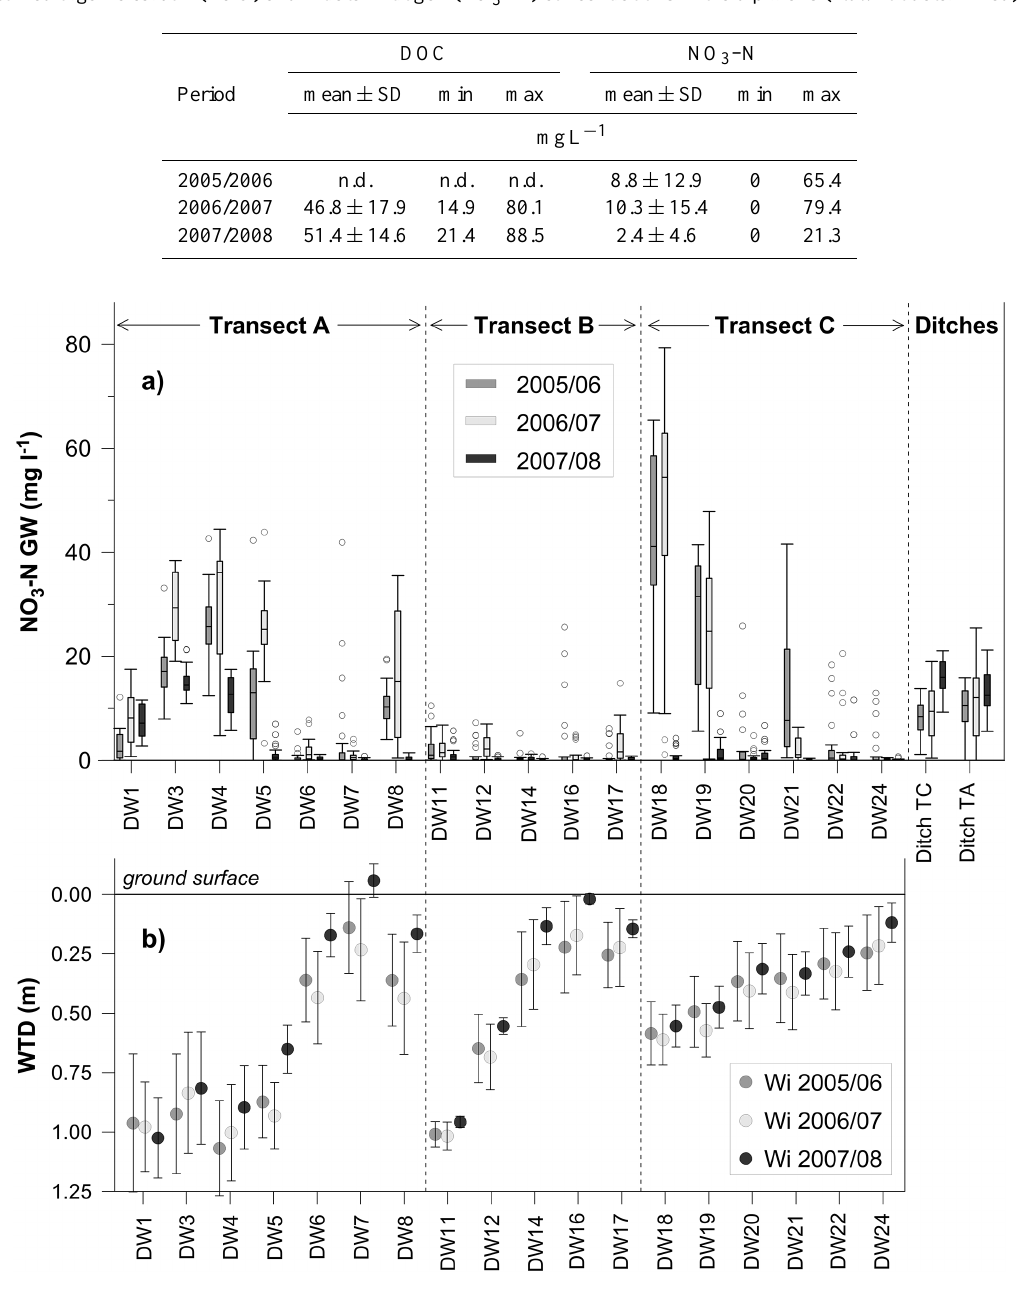
Table 3. Dissolved organic carbon (DOC) and nitrate–nitrogen (NO 3 –N) concentrations in the dip wells (n.d.: not determined).